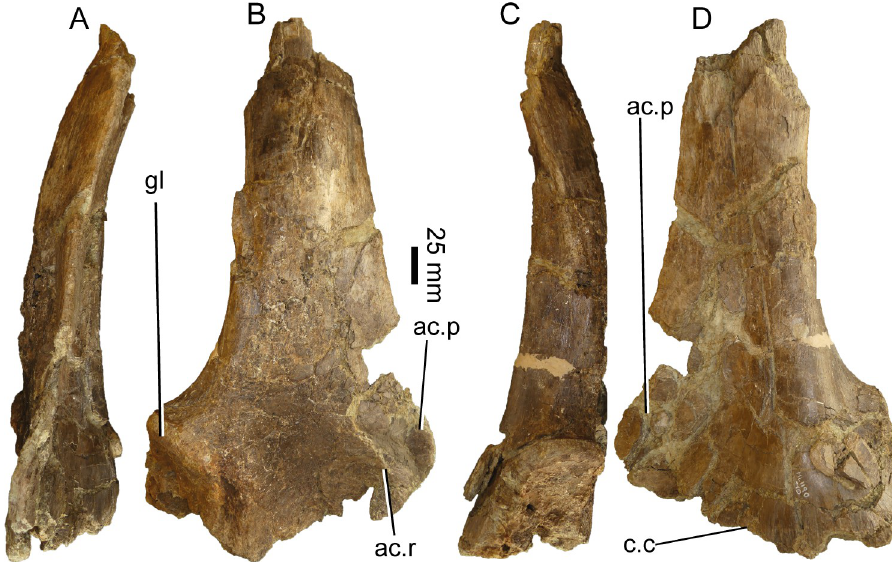
Fig 22. Partial right scapula of Iberospinus natarioi (ML1190-10). A , anterior, B , medial, C , posterior, and D lateral view. ac.p , acromion process, ac.r , acromial ridge, c.c , contact with the coracoid, gl , glenoid.